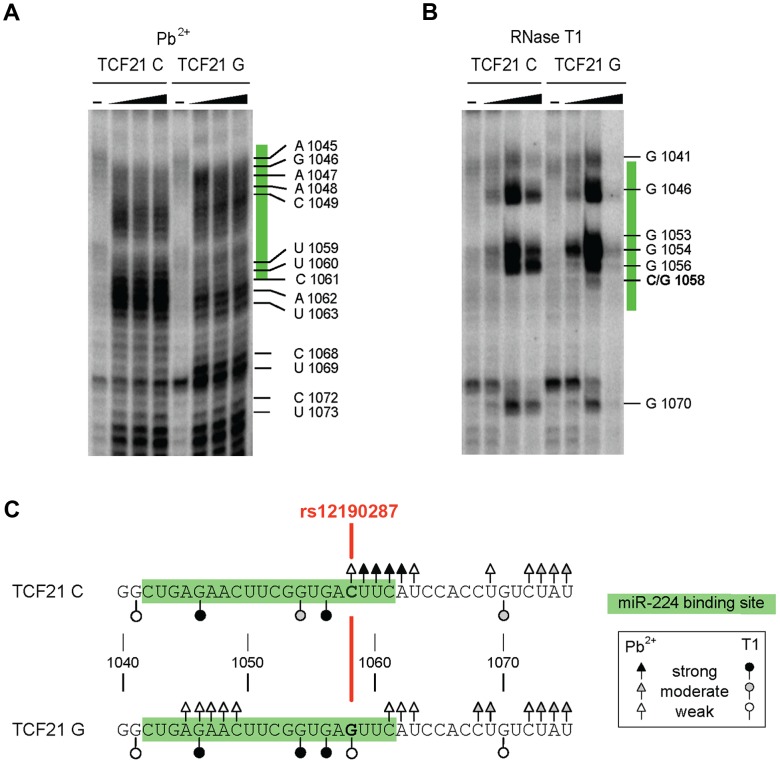
Allele-specific structural differences in conformations of TCF21 3′-UTR RNAs determined by in vitro probing.(A) Results of chemical probing of the in vitro transcribed TCF21 3′-UTR variants with varying amounts of Pb2+ (0, 10, 20 and 40 mM) and (B) enzymatic probing with varying amounts of RNase T1 (0, 0.25, 1 and 2 units). Major cleavage sites are shown along with their positions. miR-224 binding site is highlighted in green and rs12190287 is shown in red. (C) Summary of the major cleavage sites using either Pb2+ or RNase T1 and their overall cleavage strength is indicated by open and closed triangle and circles. Results are representative of at least three independent experiments.